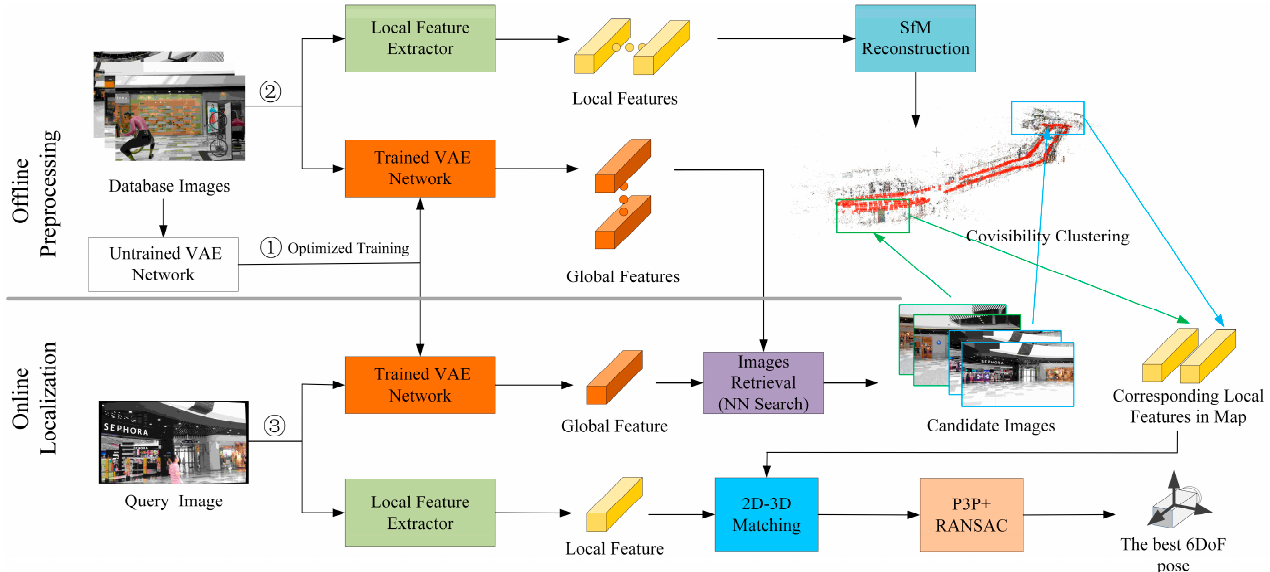
Figure 2. Overview of the unsupervised hierarchical indoor localization system. The preprocessing includes step 1 and step 2, and the localization process is step 3.